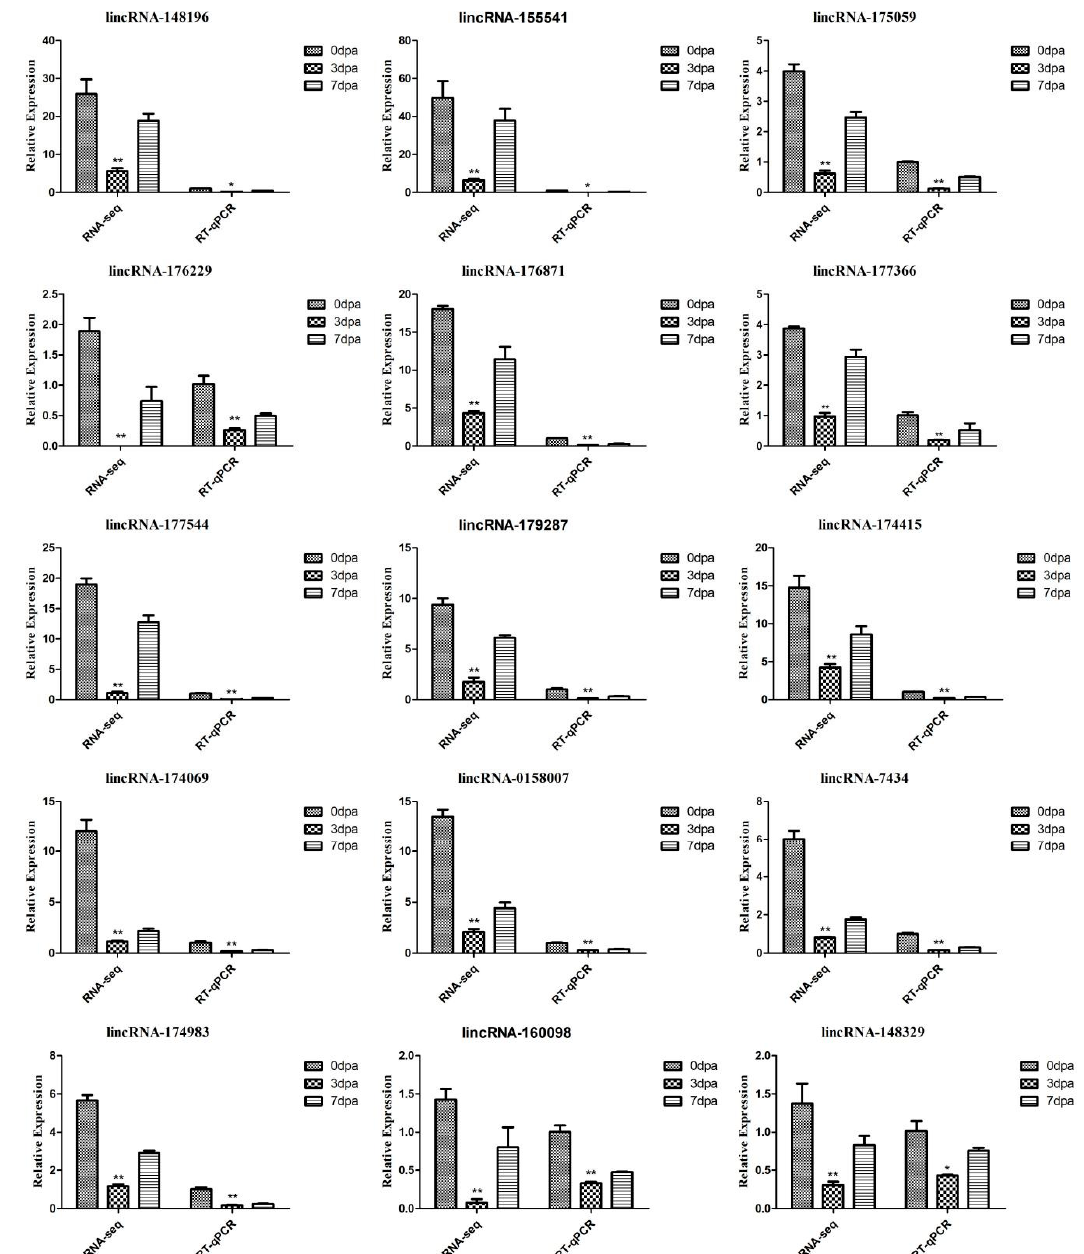
Figure 6. Verification of the differentially expressed lncRNAs with RT-qPCR: the relative expression of lncRNAs in caudal fin regeneration. Data (mean ± SEM) are representative results derived from three independent experiments. (**) p < 0.01, (*) p < 0.05, when comparing to 0 dpa.